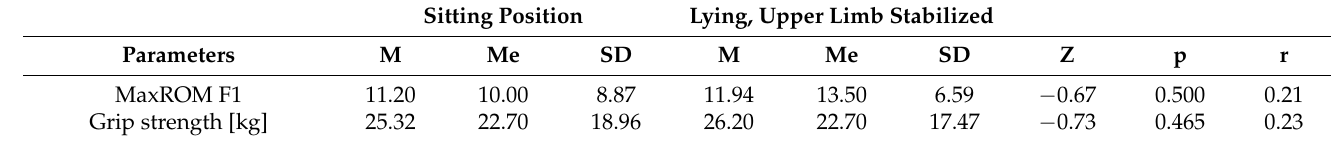
Table 6. Cont. Sitting Position Lying, Upper Limb Stabilized